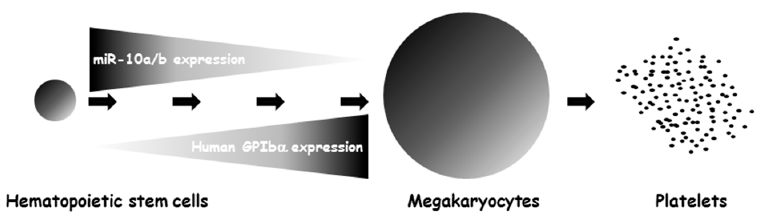
Figure 3. A schematic model illustrating how a drastic reduction in miR-10a and -10b levels allows sufficient expression of human GP Ib α and therein the GP Ib-IX-V complex in the late stage of megakaryocyte development. Because miR-10a and -10b do not introduce any mutations to the GP Ib α coding sequence and so do not alter the amino acid composition in the mature GP Ib α protein, it is unlikely that miR-10a and miR-10b can alter GP Ib-IX-V complex formation. However, sustaining high levels of miR-10a and miR-10b will cause degradation of GP Ib α mRNA, resulting in low amounts of GP Ib α protein and therein decreased expression levels of the GP Ib-IX-V complexes on the surface of the platelets. This will ultimately inhibit megakaryopoiesis and platelet production.